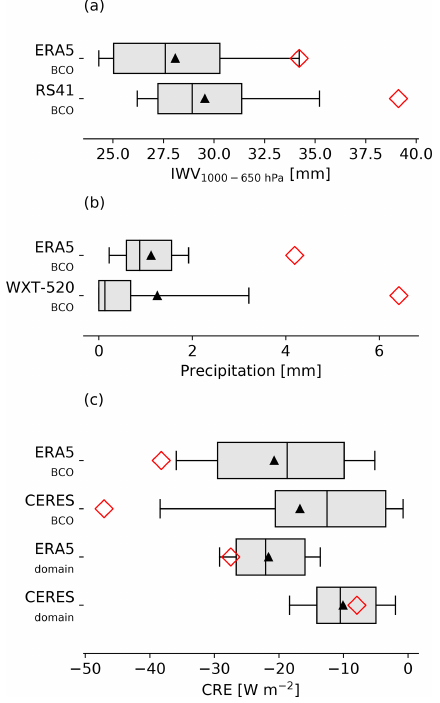
Figure 6. Boxplots of (a) daily mean IWV 1000–650hPa from ERA5 and the atmospheric soundings (RS41) at the BCO, (b) daily pre- cipitation totals from ERA5 and the weather station (WXT-520) at the BCO, and (c) daily mean CRE from ERA5 and CERES at the BCO and as area-weighted mean over the domain 10–20 ◦ N, 50– 60 ◦ W (red box in Fig. 5a; ERA5 domain and CERES domain ). The boxplots (25th, 75th percentiles as box; 10th, 90th percentiles as whiskers; median as line in the box, mean as black triangle, outliers not shown) show values of 36d (16 January to 20 February 2020). The values on 22 January 2020 are shown as red